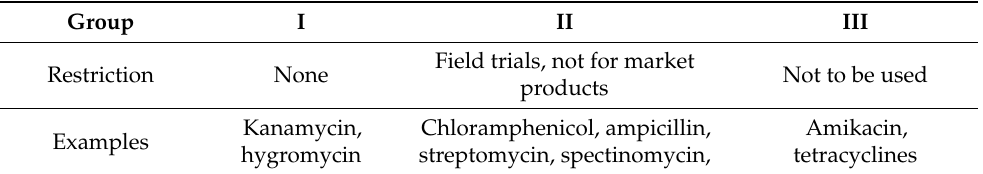
Table 1. European Food Safety Authority (EFSA)-approved uses of antimicrobial resistance genes in genetically modified organisms